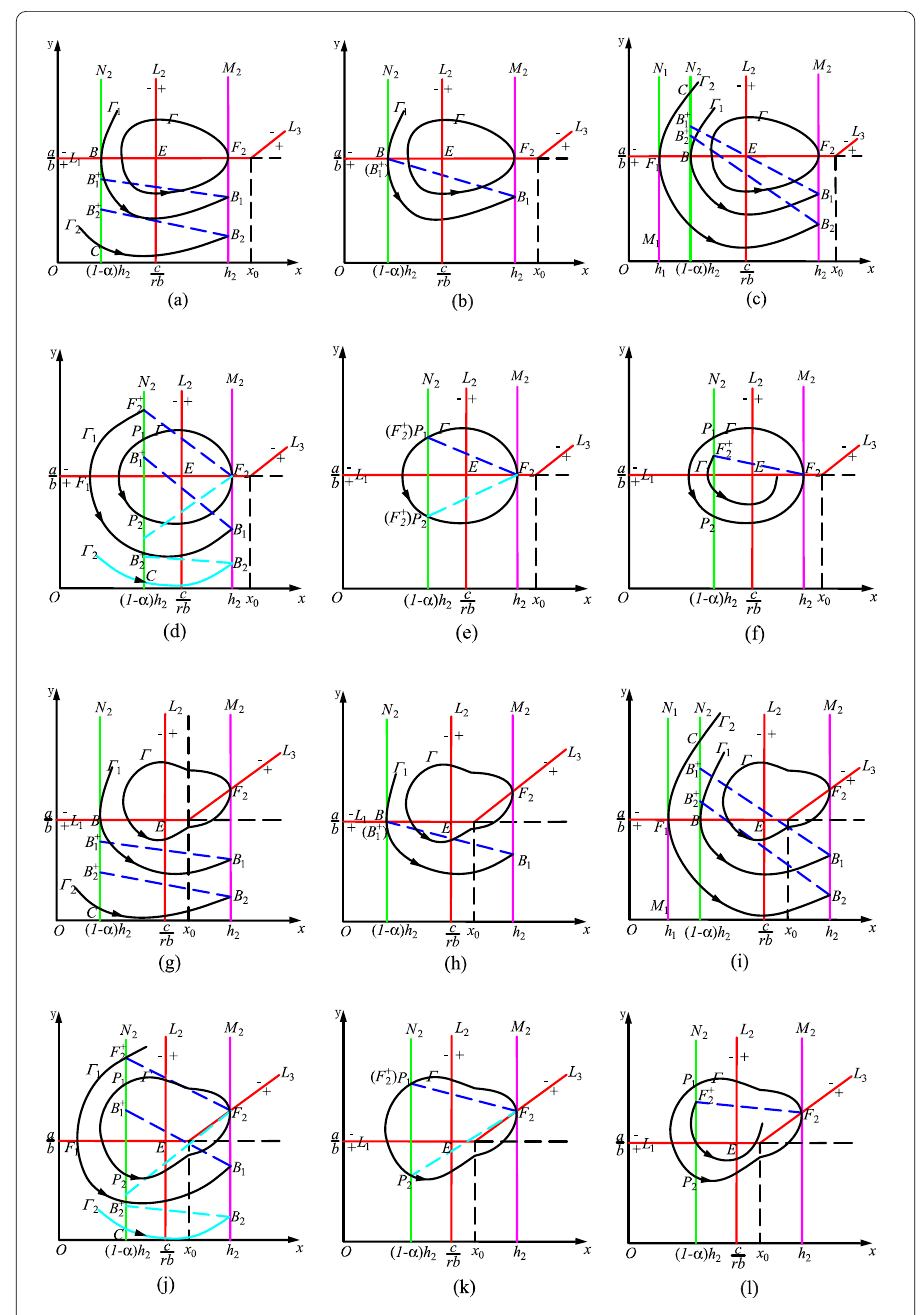
Figure 3 The orbit starting from the phase set N 2 (cases in Section 3.2). (a) Case I(a). (b) Case I(b). (c) Case I(c). (d) Case II(a). (e) Case II(b). (f) Case II(c). (g) Case III(a). (h) Case III(b). (i) Case III(c). (j) Case IV(a). (k) Case IV(b). (l) Case IV(c).